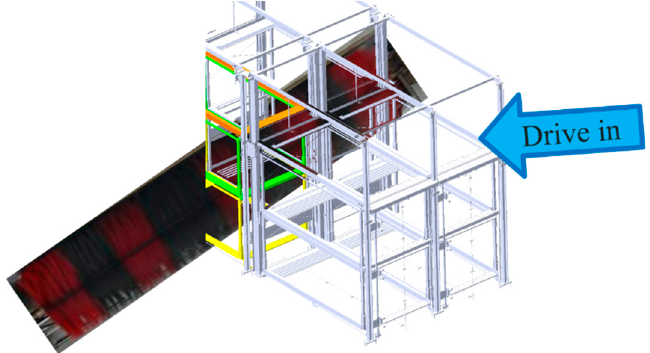
Figure 16. 3D Sketch of the SOI.